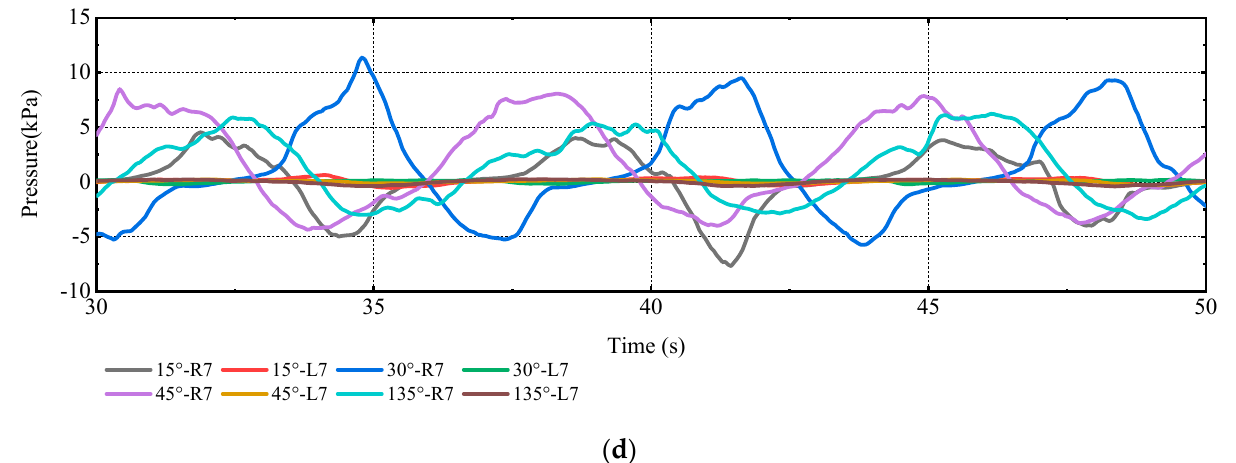
Figure 16. Time histories of slamming pressure at the important positions. ( a ) Centerline of the bow of main hull; ( b ) Side of main hull; ( c ) Side hull; ( d ) Cross-deck.